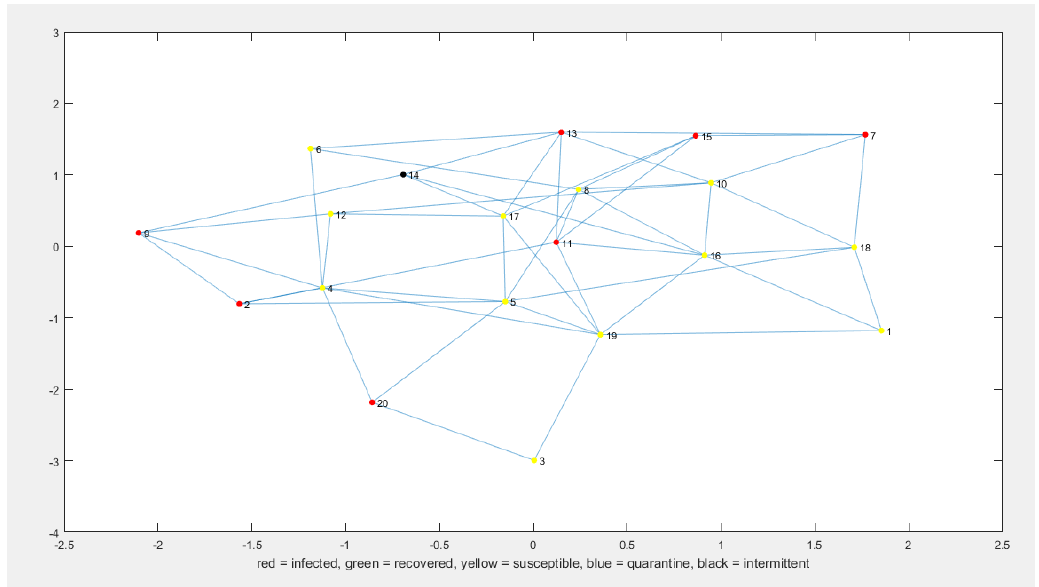
Figure 9. Node-state graph at time t = 4. Node 1 has moved and its neighbouring nodes have changed.